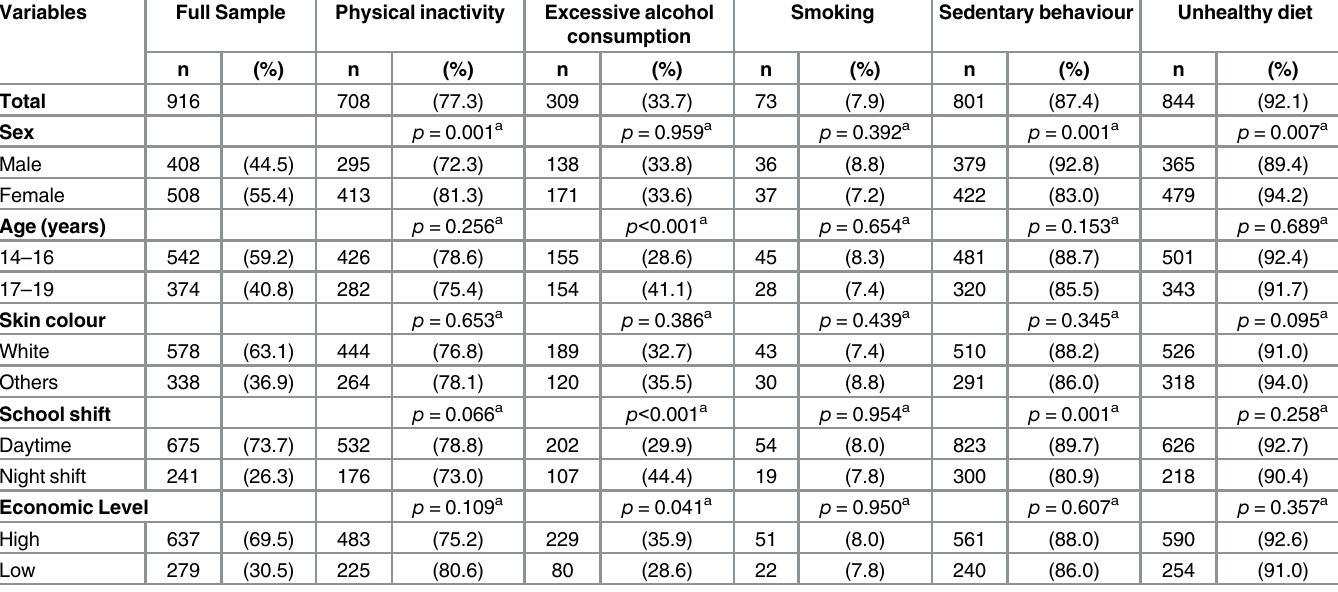
Table 2. Risk factor characteristics of the adolescents according to demographic and socioeconomic